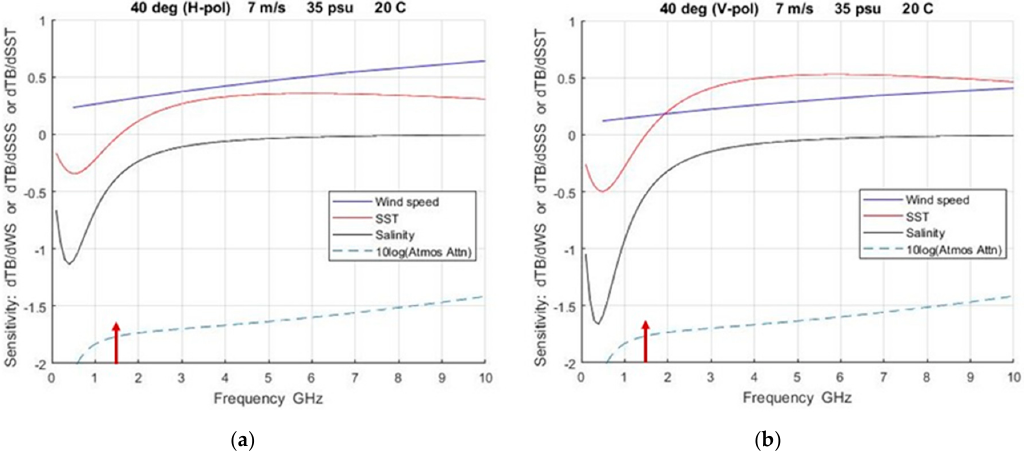
Figure 14. Expanded view of sensitivities shown in Figure 13 with more frequency resolution in the range relevant to remove sensing of SSS: ( a ) Horizontal polarization; ( b ) Vertical polarization. The arrow indicates 1.4 GHz.